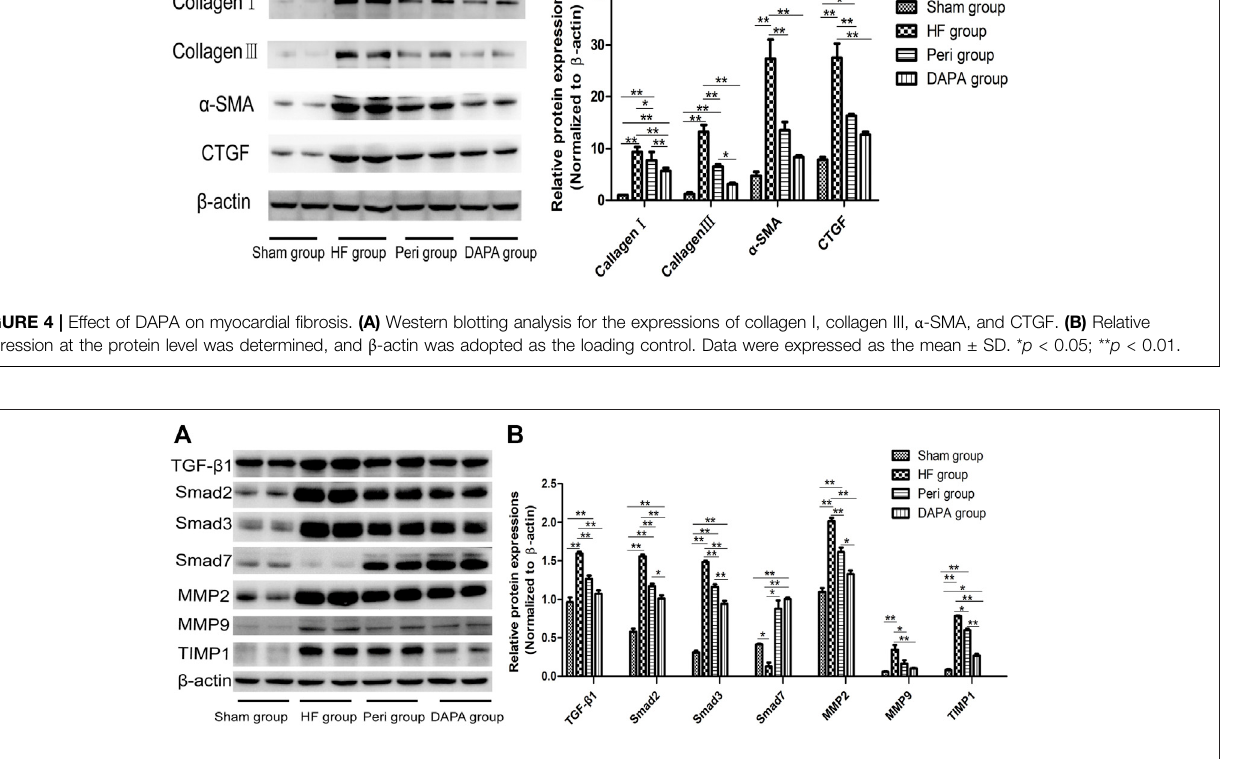
FIGURE 5 | Effect of DAPA on the TGF- β 1/Smad pathway in vivo . (A) Western blotting analysis for the expressions of the TGF- β 1/Smad pathway. (B) Relative expression at the protein level was determined, and β -actin was adopted as a loading control. Data were expressed as the mean ± SD. * p < 0.05; ** p < 0.01.